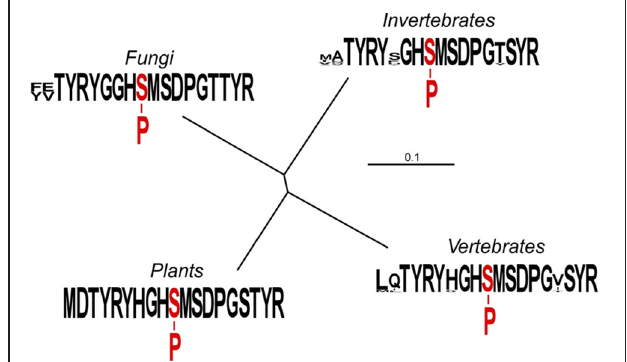
FIGURE 1 | Relationships among the amino acid sequences immediately flanking phosphorylation site 1 of mitochondrial PDC E1 α . The un-rooted tree was generated with TreeView version 1.6.6 (http://taxonomy.zoology.gla.ac.uk/rod/treeview.html). Each clade comprises 10 randomly selected sequences. The plant clade includes sequences of the “tryptic peptide” from Pisum sativum, A. thaliana, Glycine max, Lycopersicon esculentum, Solanum tuberosum, Beta vulgaris, Medicago truncatula, Zea mays, Oryza sativa , and Triticum aestivum . The sequences are identical. The vertebrate clade includes sequences from Homo sapiens, Rattus norvegicus, Gallus gallus, Macaca fascicularis, Xenopus laevis, Danio rerio, Oryctolagus cuniculus, Ailuropoda melanoleuca, Heterocephalus glaber , and Capsaspora owczarzaki . The invertebrate clade includes sequences from both nematodes and insects; Ascaris suum, Caenorhabditis elegans, Bombyx mori, Aedes aegypti, Drosophila melanogaster, Daphnia pulex, Tribolium castaneum, Solenopsis invicta, Amblyomma maculatum , and Batrachochytrium dendrobatidis . The fungal clade includes sequences from Saccharomyces cerevisiae, Schizosaccharomyces pombe, Kluyveromyces lactis, Naumovozyma dairenensis, Clavispora lusitaniae, Meyerozyma guilliermondii, Schizophyllum commune, Fusarium oxysporum, Verticillium alboatrum , and Ajellomyces capsulatus . The clade sequence presentations were assembled using WebLogo (Crooks et al., 2004).